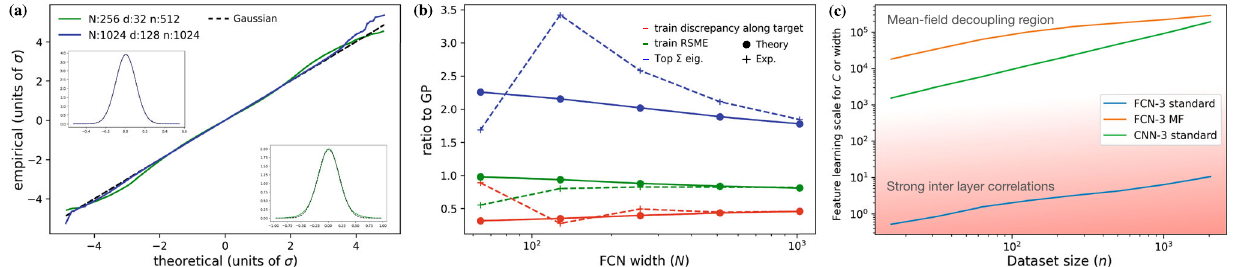
Fig. 2 | Theory versus experiment. a , b Compare fully trained 3-layer FCNs in the MFscalingwithourtheoreticalpredictions. a Studiesthemoststrongly fl uctuating weight mode in the fi rst layer. A QQ-plot is shown, of its empirical distribution againstanormalone,alongwithhistogramstogetherwithGaussian fi ts(insets).As the scale of the problem increases, these fl uctuations become more and more Gaussian. b TheexperimentalvaluesandEoSpredictions,eachnormalizedbytheir values at N l → ∞ with fi xed σ l (i.e. the GP value). Here we used n =1024 and d =128. c Plots the N (or channelnumber C ) atwhich the featurelearning scale( χ ) is 1.